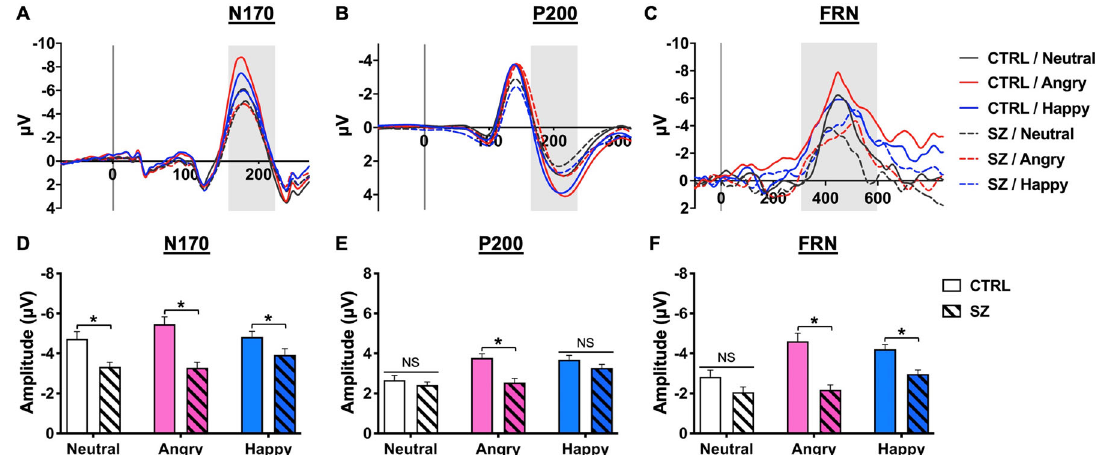
Fig. 2 EEG results. A – C Grand averaged waveforms of the N170, P200, and FRN for the control (CTRL, solid lines) and patients with schizophrenia (SZ, dashed lines) groups in the neutral (gray lines), angry (red lines), and happy (blue lines) conditions. D – F Mean (±SEM) amplitudes of the N170, P200, and FRN for the healthy controls (CTRL, open bars) and patients with schizophrenia (SZ, striped bars) groups in the neutral (white bars), angry (pink bars), and happy (blue bars) prime conditions. * p < 0.05 between CTRL and SZ groups in the facial prime